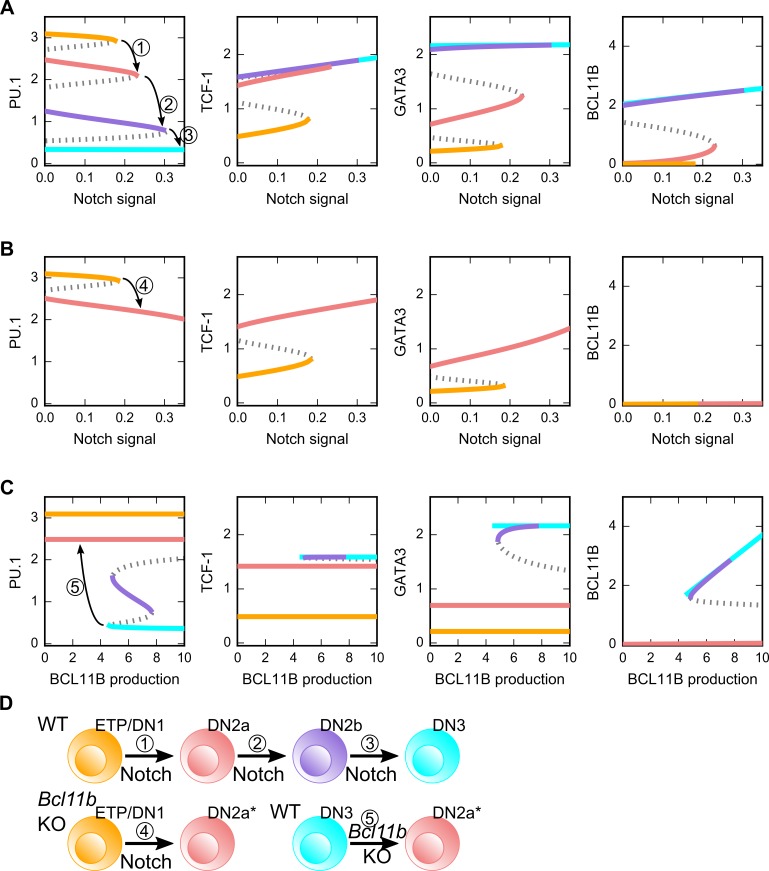
Stability analysis of the T cell model.The full model shown in Fig 4A is used for all the analysis. A. Bifurcation diagrams for the steady states of the four core factors with respect to the Notch signal. Solid curve: stable steady state. Dashed curve: unstable steady state. B. Bifurcation diagram under Bcl11b knockout condition with respect to Notch signal. Solid curve: stable steady state. Dashed curve: unstable steady state. C. Bifurcation diagram with respect to BCL11B production rate parameter. Solid curve: stable steady state. Dashed curve: unstable steady state. D. Illustration of the observed transitions among the four states. Colors of the stable branches of the bifurcation diagrams and the cell icons are matched to the cellular states shown in Fig 1.